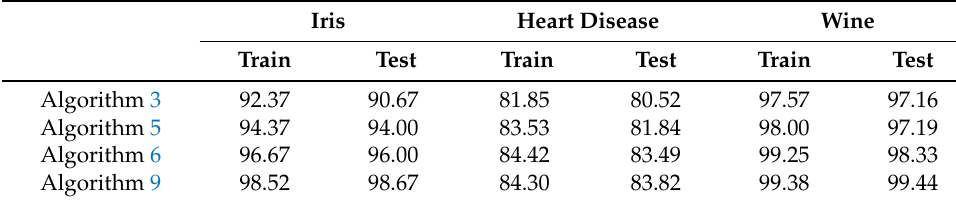
Table 4. Average accuracy of each algorithm at the 300th iteration with 10-fold